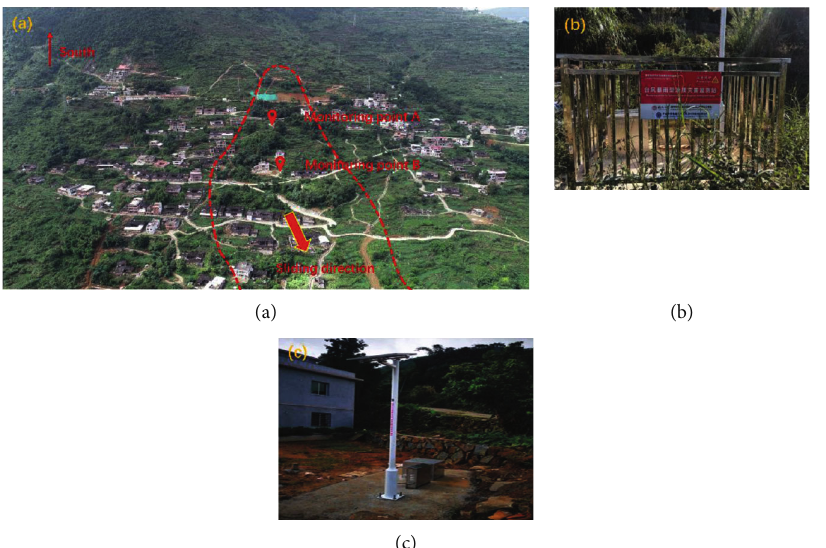
Figure 4: Schematic diagram of the landslide area and monitoring points. (a) Landslide area and monitoring point locations. (b) Monitoring point A. (c) Monitoring point